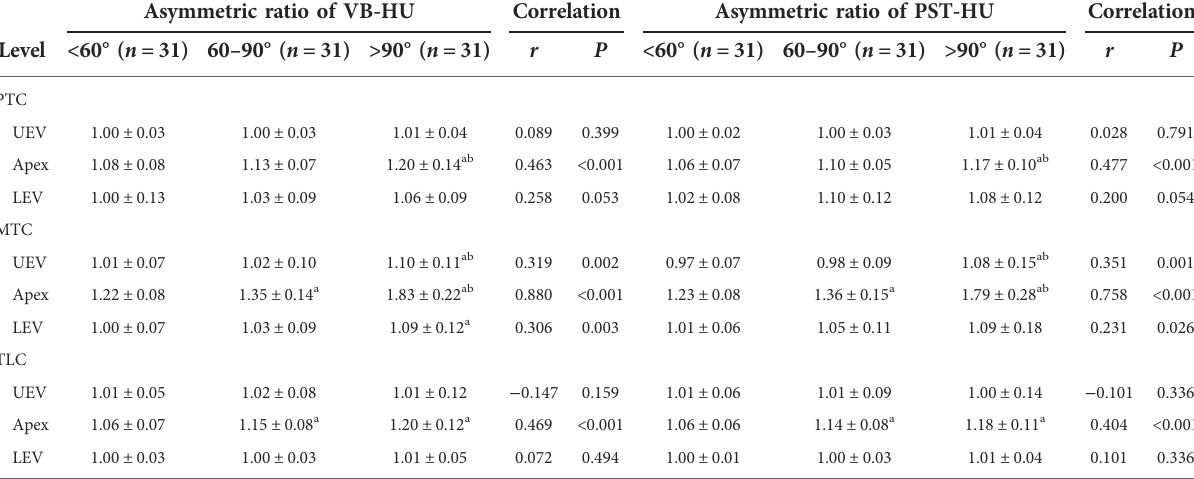
TABLE 6 Correlation between asymmetric HU ratio and cobb angle of major and minor curves. Asymmetric ratio of VB-HU